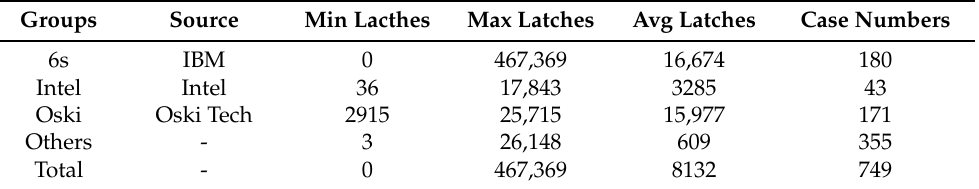
Table 3. The categories of